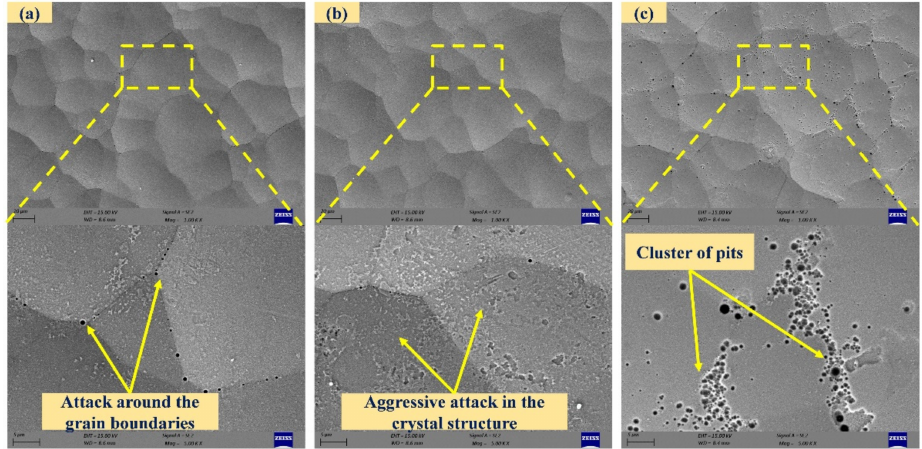
Figure 10. SEM images of chemically treated surfaces with 5% hydrofluoric acid (( a – c ): exposure times of 10, 20, and 30